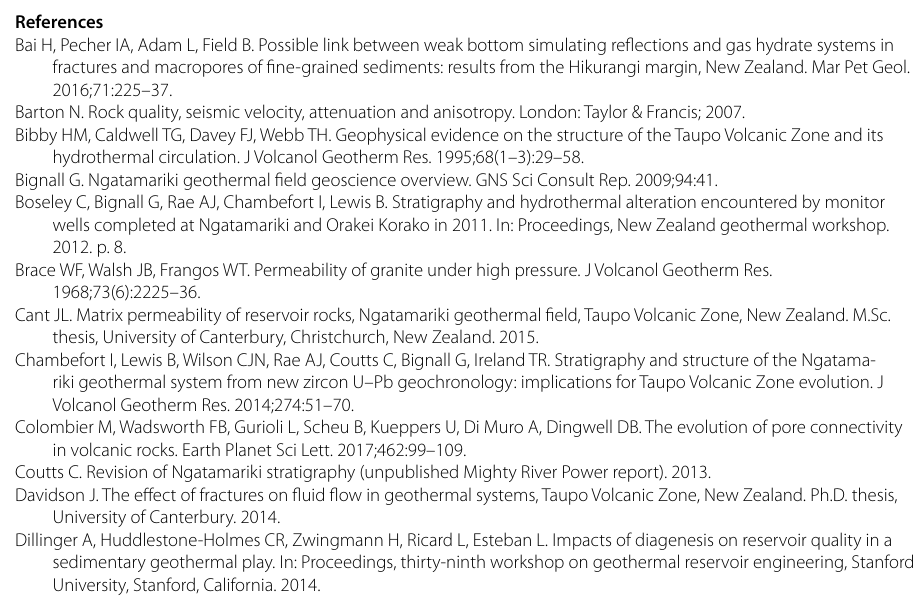
Porphyritic microdiorite– diorite Quartz-bearing diorite